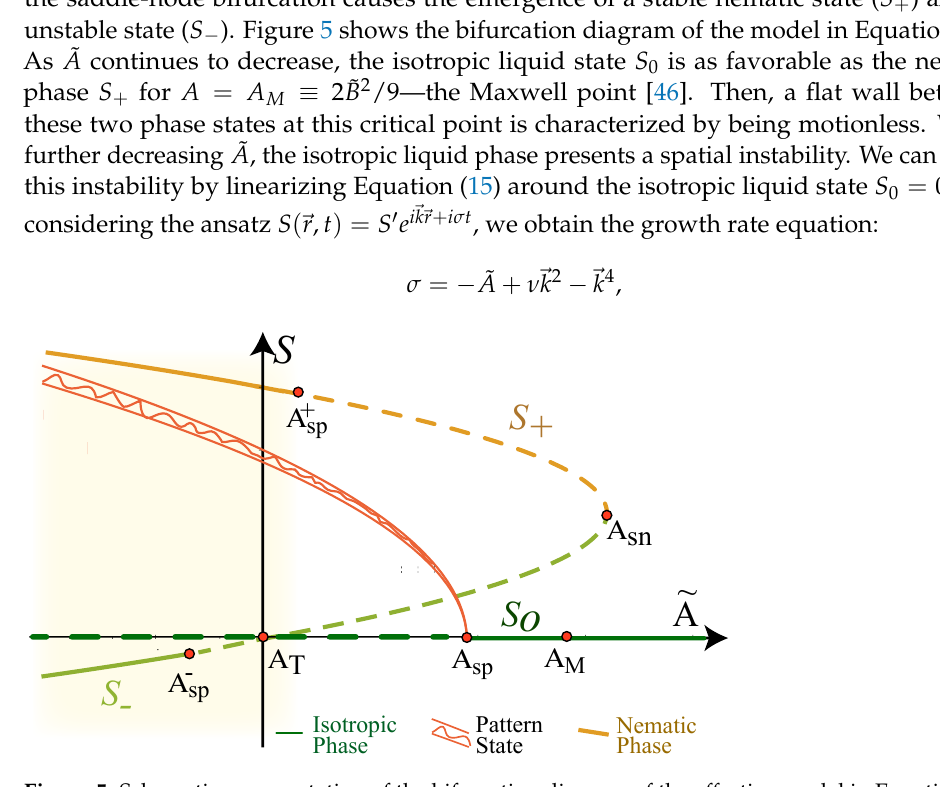
Figure 5. Schematic representation of the bifurcation diagram of the effective model in Equation (15) with constant coefficients. The order parameter S as a function of the bifurcation parameter ˜ A . S 0 , S + , and S − account for the isotropic liquid and nematic phases, respectively. The continuous and dashed lines account for stable and unstable states respectively. A sn , A M , and A T are the critical points that account for the emergence of the nematic phase; both phases are equally favored, with a transcritical bifurcation of the isotropic liquid phase. A sp , A + sp , and A − sp account for the spatial instabilities of the homogeneous phases. The painted area shows the region of coexistence between the periodic state and the homogeneous state. The decorated curve explains the amplitude of the